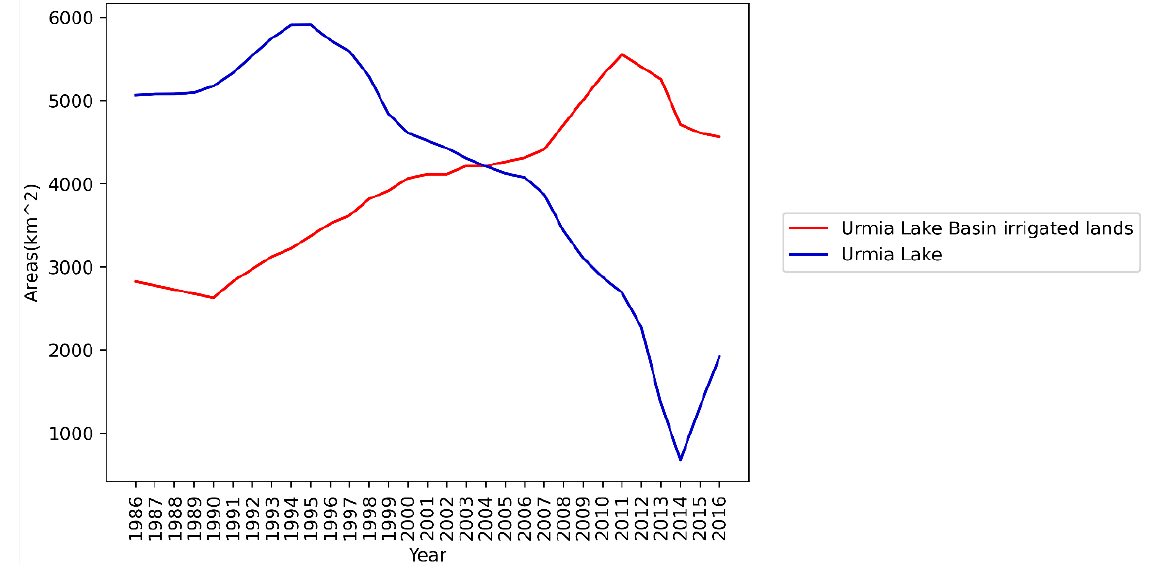
Figure 9. Agricultural development and Urmia Lake area changes in the Urmia Lake Basin from 1986 to 2016 [72].